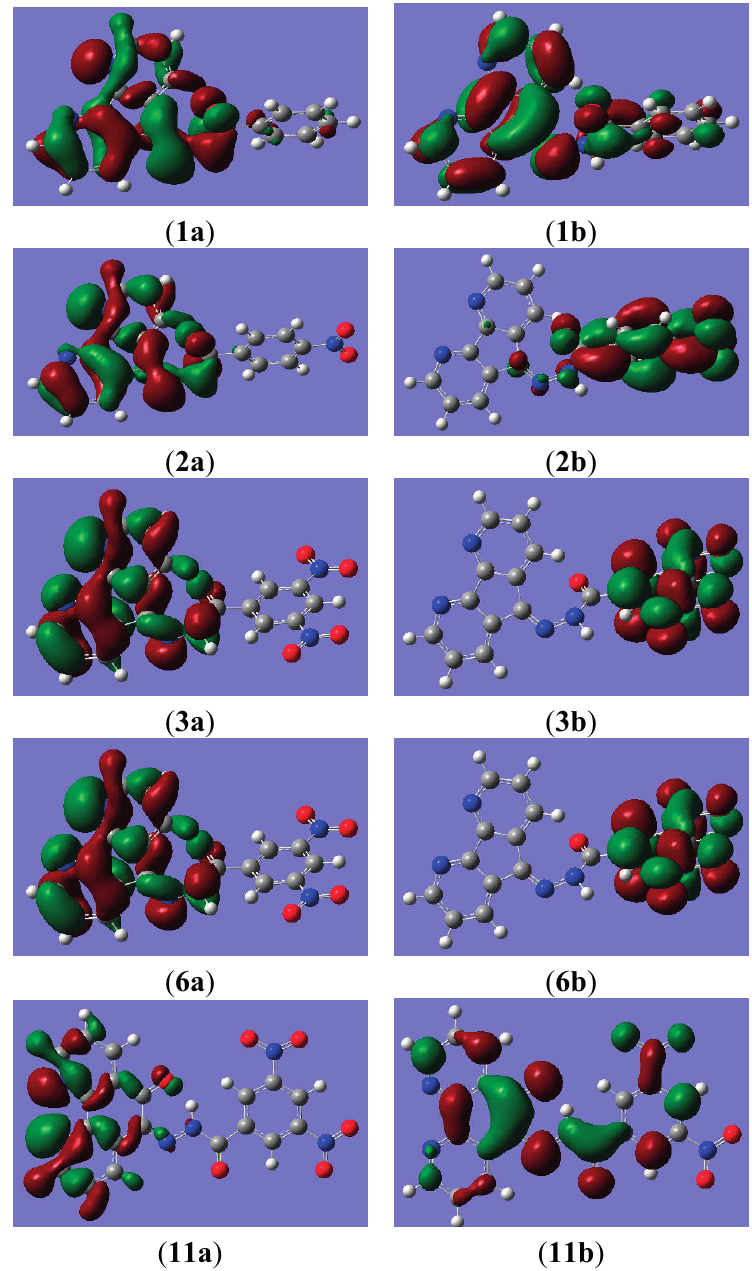
Figure 6. Selected HOMO ( a ); and LUMO ( b ) distributions of 1 , 2 , 3 , 6 and 11